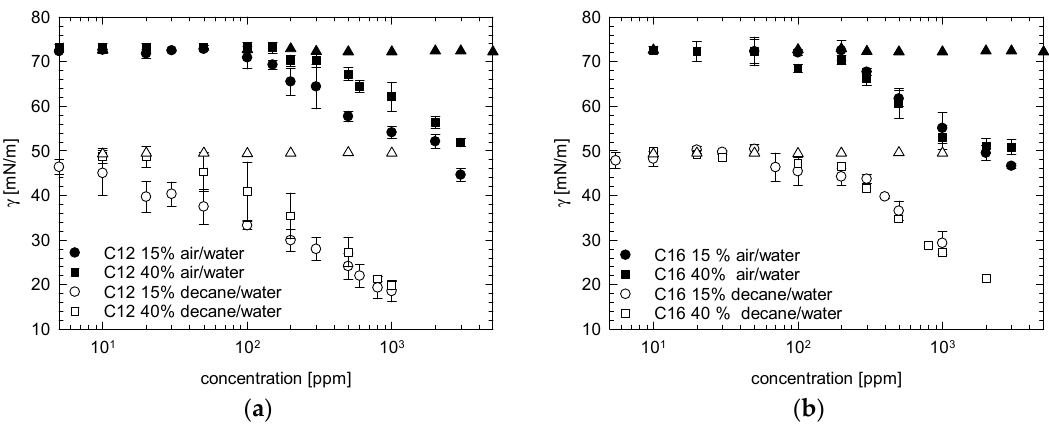
Figure 2. The dependence of the surface tension at air/solution and of interfacial tension at decane/solution interface on copolymer mass concentration. ( a ) For PSS/MA-g-C 12 NH 2 ; ( b ) for PSS/MA-g-C 16 NH 2 . Triangles denote surface/interfacial tension for unmodified PSS/MA copolymer at air/water (black symbols) and decane/water (white symbols) interface, re- spectively.